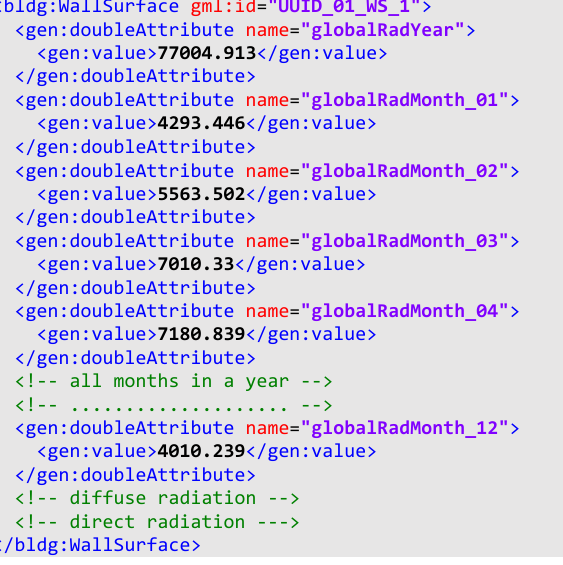
Figure 1. Textures of the global irradiation values for the months (left to right): February, March, April, and May As depicted in figure 2, the monthly estimates for the three irradiation types direct, diffuse, and global for a facade surface are visualized in a web client for 3D city models as an attribute table. This data visualization has some limitations, as it makes it hard for the viewer to quickly grasp relevant information from the data. For instance, the table representation does not allow to directly observe the full range of the data, as it will usually not be possible to view the monthly attributes for direct, diffuse and global irradiation at the same time, because a table of that size would not fit on the screen. More difficulties arise, when trying to compare the three variables to each other or recognize monthly deviations. The usability of such analyses will drastically be improved, if city model standards allow time- dependent variations of such result values to a common generic attribute as illustrated by the dynamizer concept in section